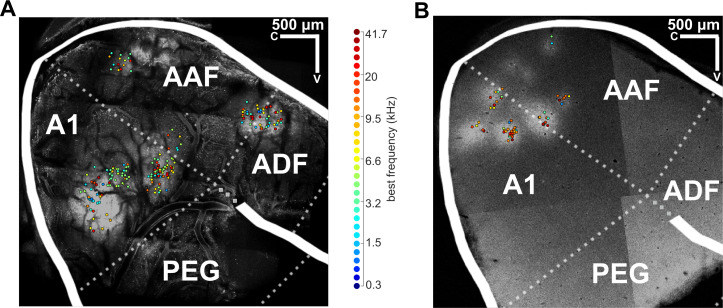
Mapping data from individual ferrets onto a common template of auditory cortex.(A) An image of the brain surface of ferret 3, acquired in vivo using two-photon calcium imaging. Individual frequency-sensitive neurons imaged across all fields are plotted on this map according to their anatomical position, where their color indicates their BF (color scale, right). The common template of auditory cortex is superimposed, where white solid lines indicate sulci and white dotted lines indicate approximate borders between known cortical fields (names in white text). The brain image and template were aligned according to the positions of sulci, and frequency responses of imaged neurons. Only neurons in A1 were included in our analyses. (B) A post mortem section of the auditory cortex of ferret 7, which was sliced parallel to the two-photon imaging plane (i.e. parallel to the surface of auditory cortex) and imaged with a confocal microscope. The BF of imaged neurons and the cortical template are superimposed, as in (A). A1 = primary auditory cortex; AAF = anterior auditory field; PEG = posterior ectosylvian gyrus (containing the posterior pseudosylvian and posterior suprasylvian fields); ADF = anterior dorsal field.